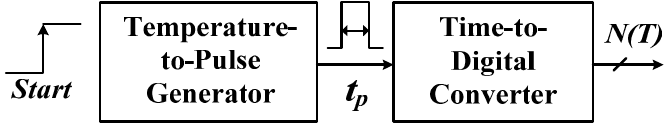
Figure 1. Architecture of first time-domain smart temperature sensor.